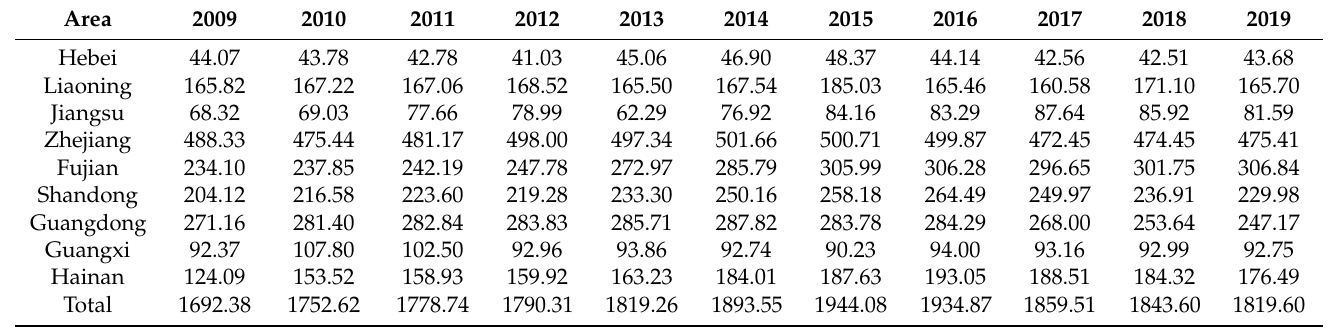
Table 5. Carbon emissions from marine fisheries in nine coastal provinces from 2009 to 2019 year (10,000 tons).